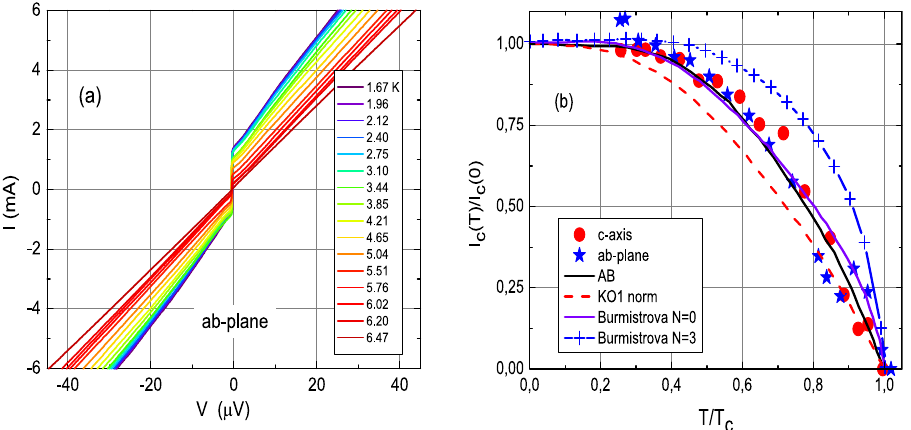
Figure 3. ( a ) I − V characteristics of a Pb 0.6 In 0.4 / Ba 0.6 K 0.4 (FeAs) 2 point-contact Josephson junction, recorded in zero magnetic and zero microwave fields at different temperatures. ( b ) Symbols: measured normalized critical currents I c ( T ) / I c ( 0 ) as a function of the normalized temperature T / T c for a PC with a current injection along the ab plane (blue stars) and for a contact with current along the c -axis (red circles). Lines: theoretical dependencies for (1) an Ambegaokar–Baratoff (AB) 36 S / I / S tunnel contact between “ordinary” superconductors (black, solid), (2) contacts with current injection parallel to the ab plane between an “ordinary” S and a two-band s ± superconductor 15 in the case of a direct microshort (solid line, violet) and a tunnel contact (line and crosses, blue) and (3) for Kulik–Omelyanchuk (KO1) dirty S / S microshorts 37 (red dashed line).